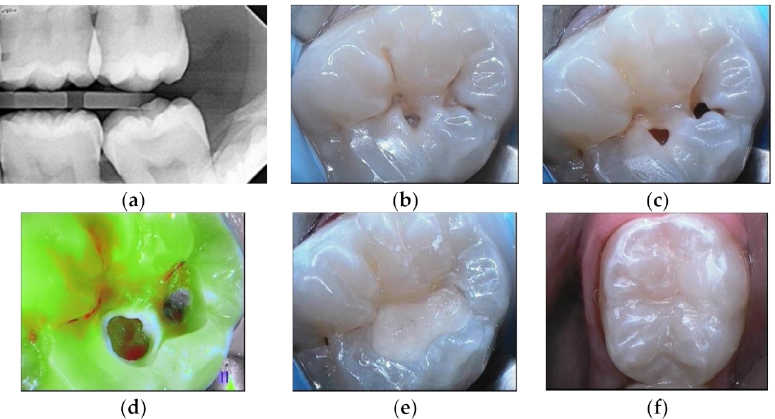
Figure 2. Lower molar with extensive occlusal cavities. ( a ) Preoperative radiograph. ( b ) Daylight image before cleaning. ( c ) Tooth after cleaning with sodium bicarbonate airflow. ( d ) Fluorescence image of the tooth during cavity preparation (Soprolife TM camera). ( e ) GIC application as a liner. ( f ) Resin composite restoration.